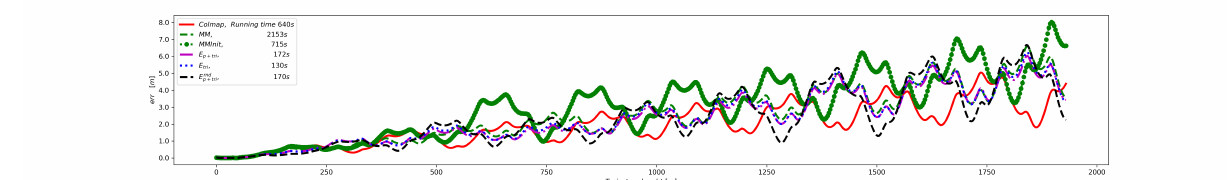
Figure 3. CAR dataset. Average position error ( err ) along the trajectory w.r.t. ground truth for several structure approximation variants: E rnd p + tri in black dashed line, E p + tri in continuous magenta line, E tri in dotted blue line. MM (green dashed line) and MM Init (green dash-dotted line) are the sequential and global SfMs in MicMac (Pierrot Deseilligny and Cl´ery, 2011), and in red continuous like it is Colmap’s SfM (Schonberger and Frahm, 2016). MicMac and Colmap results were computed with with SIFT (Lowe, 2004). In variant E rnd p + tri a mean value over 100 repeated calculations is reported. The high frequency drift is due to the cyclic nature of the acquistion geometry.